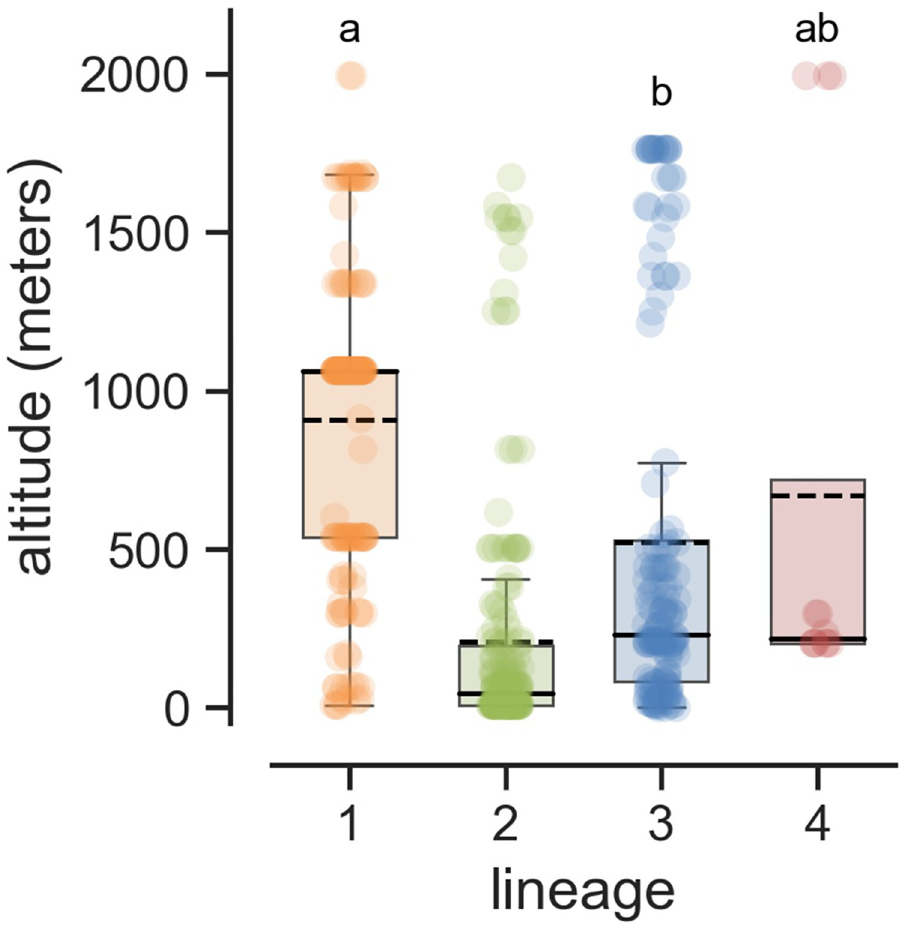
Fig 6. Altitudinal distributions of four lineages of P . oryzae . Dashed and solid black lines represent the mean and median, respectively. Shared superscripts indicate non-significant differences (Mann-Whitney post-hoc tests, p- value > 0.05, Holm-Bonferroni